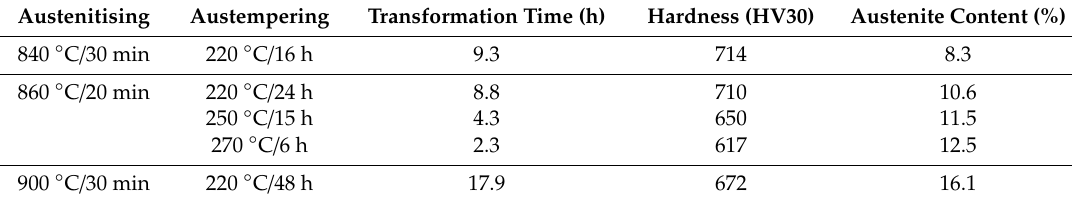
Table 3. Austenitising and austempering conditions investigated, and the corresponding transformation times, hardness values, and retained austenite contents of the resulting microstructures, as determined by